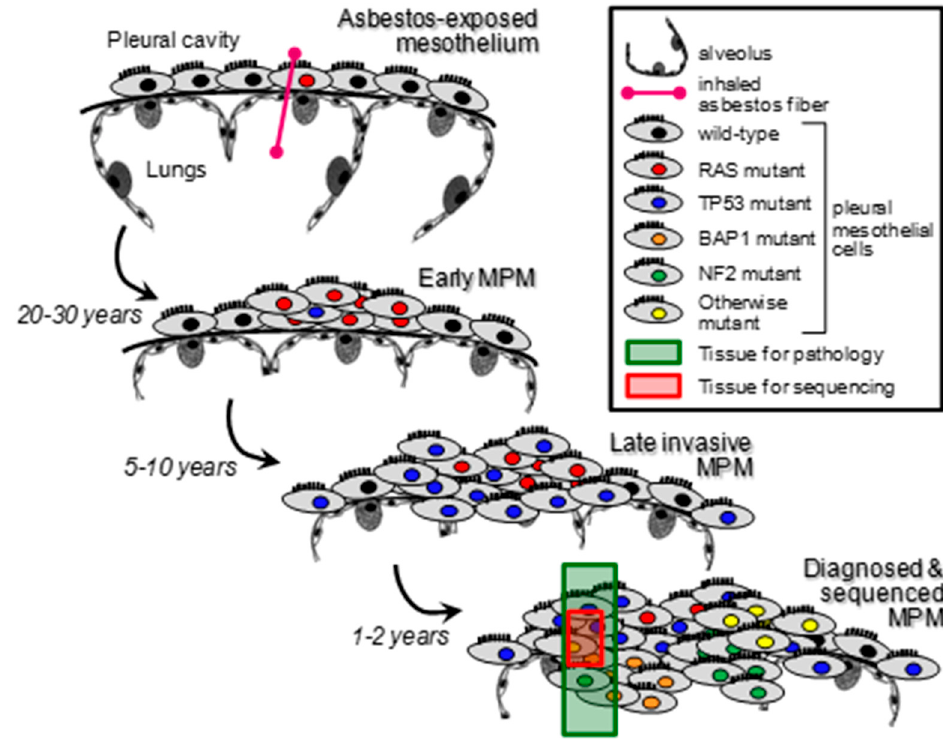
Figure 3. Schematic representation of the scenario for KRAS pathway alterations missed by next generation sequencing studies via sampling and allelic frequency bias. The sporadic nature of KRAS pathway alterations in MPM is compatible with both their possible early tumorigenicity, as well as with late clonal or sub-clonal natures. Given their low allelic frequency, however, the most likely explanation of the findings presented here is the later scenario, coupled with sampling bias.